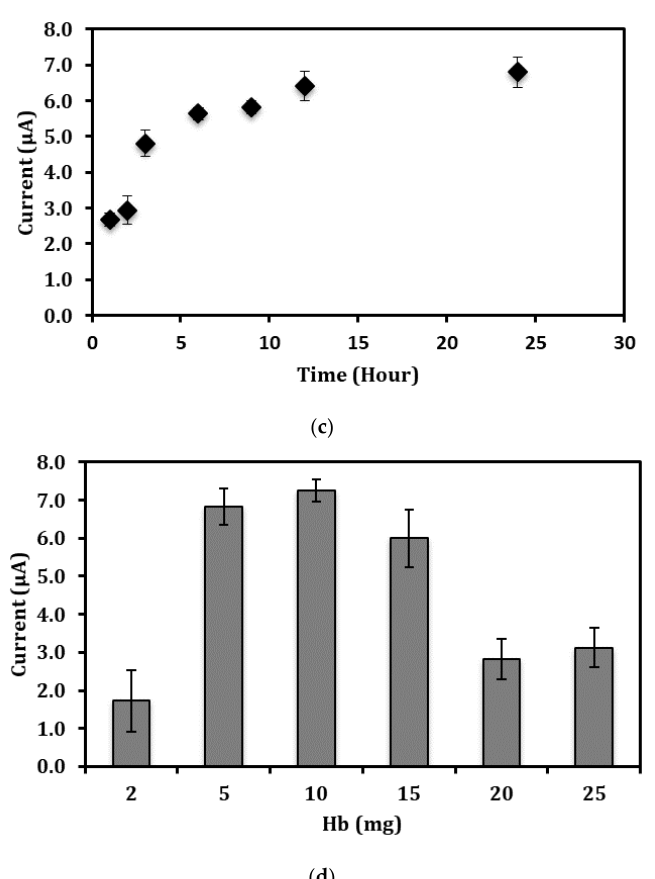
Figure 4. The composition ratio between rGO and acrylic precursor [rGO:poly(nBA)] ( a ), NAS ( b ) Hb immobilization time ( c ) and Hb concentrations’ effects ( d ) on the voltammetric nitrite biosensor response. The reaction was performed in the 0.05 M potassium phosphate buffer at pH 5.5 containing 1 ppm nitrite.